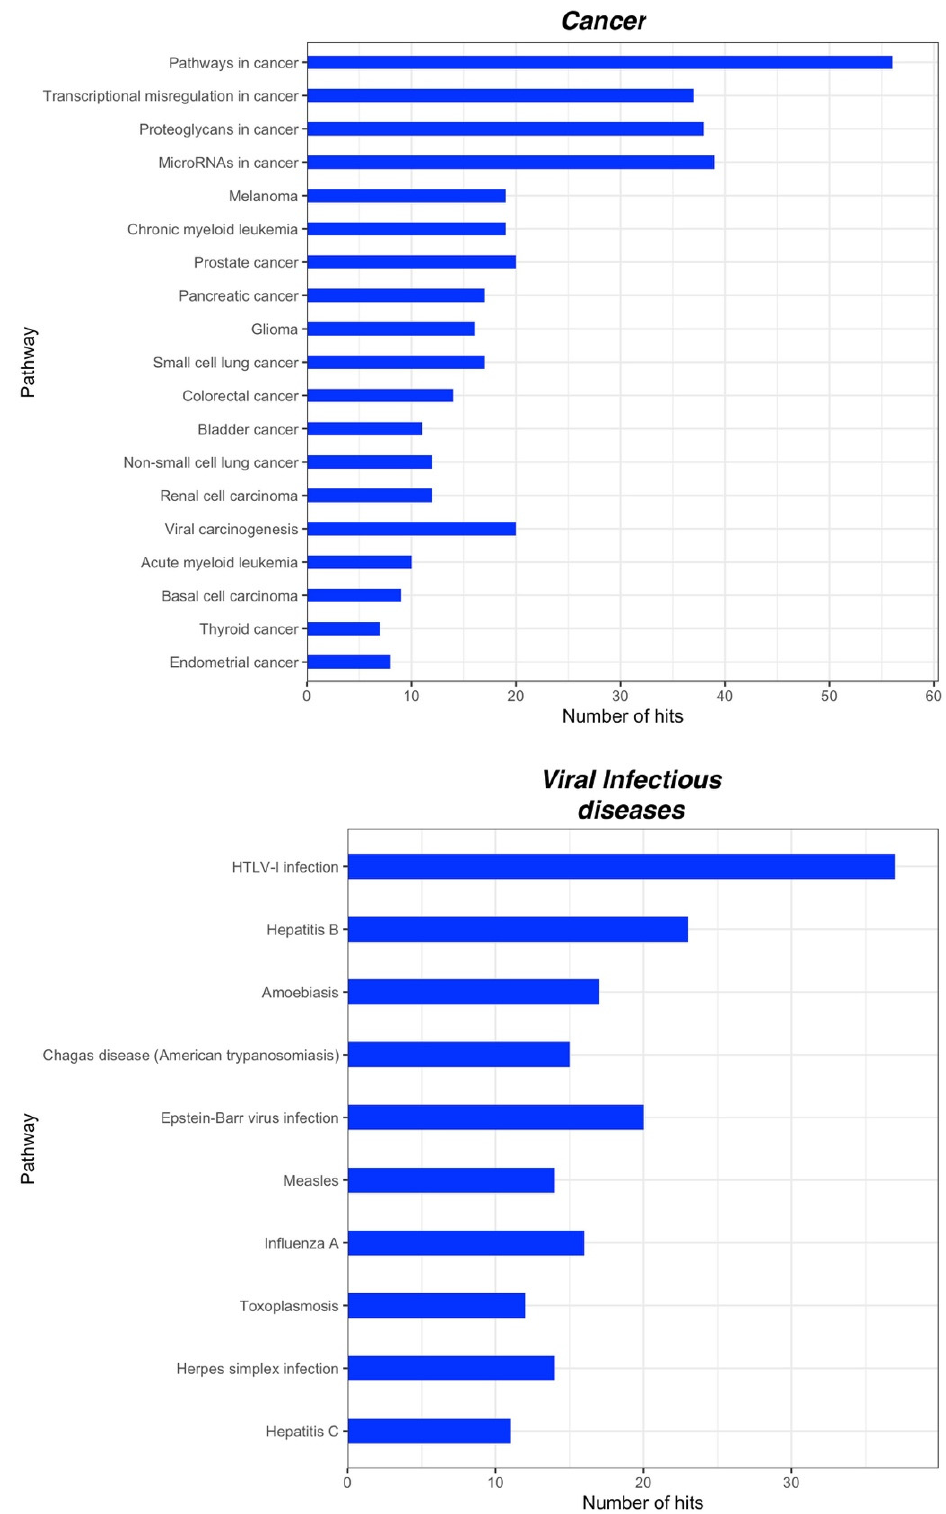
Figure 4. KEGG pathways related to diseases significantly associated with miRNA targets in CPP (within each group, pathways are arranged according to their p -values, in descending order). Adjusted p -values were calculated using Benjamini-Yekutieli method.